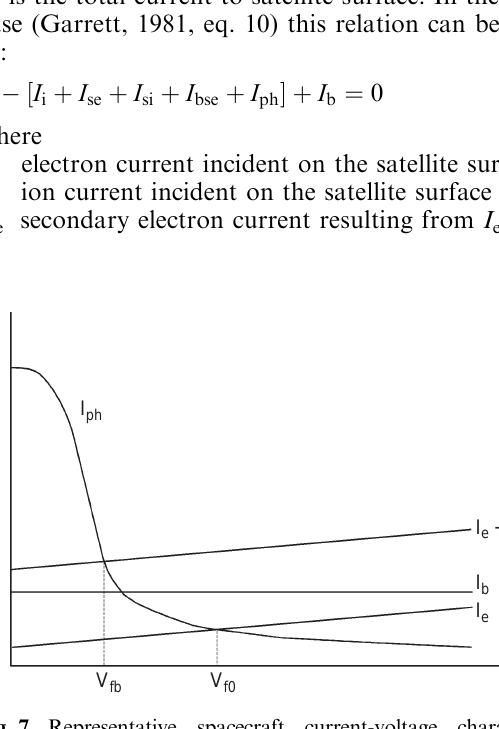
Fig. 7. Representative spacecraft current-voltage characteristics, showing the e(cid:128)ect of active ion emission on the